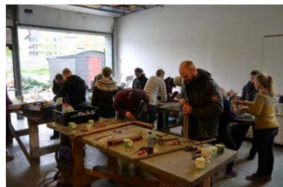
Figure 14. Workshop session on window restauration (Svartlamon residents association,